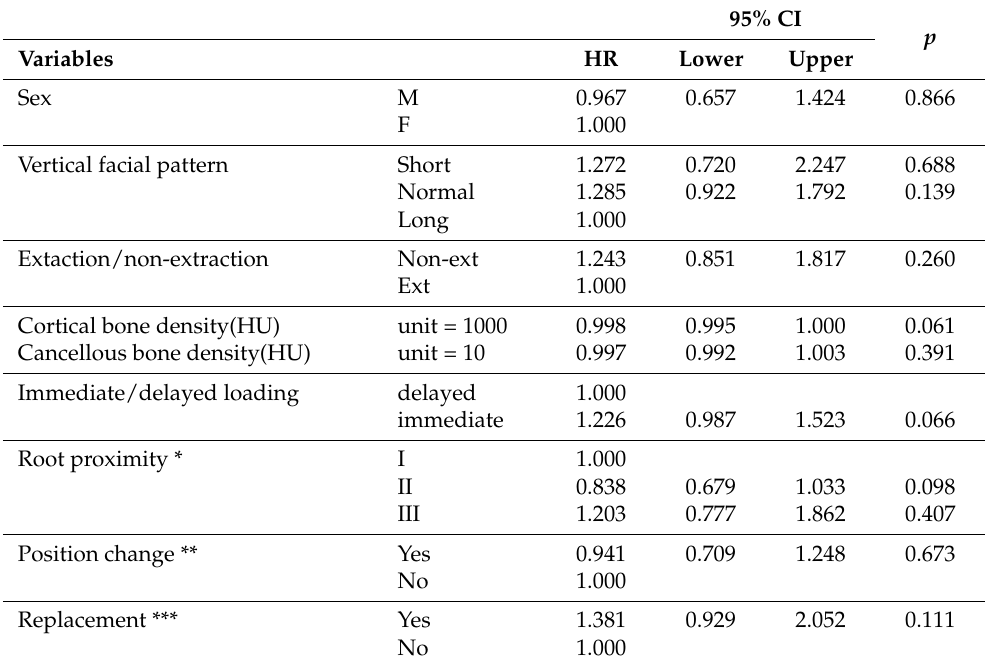
Figure 2. The marginal survival plot showing high overall survival rate for micro-implants. Variables that showed borderline non-significance (0.05 < p < 0.10) were cortical bone density ( p = 0.061), loading protocol ( p = 0.066 for immediate loading), and root proximity ( p = 0.098 for type II, Table 4). Table 4. Univariable marginal survival analysis for factors associated with micro-implant success.